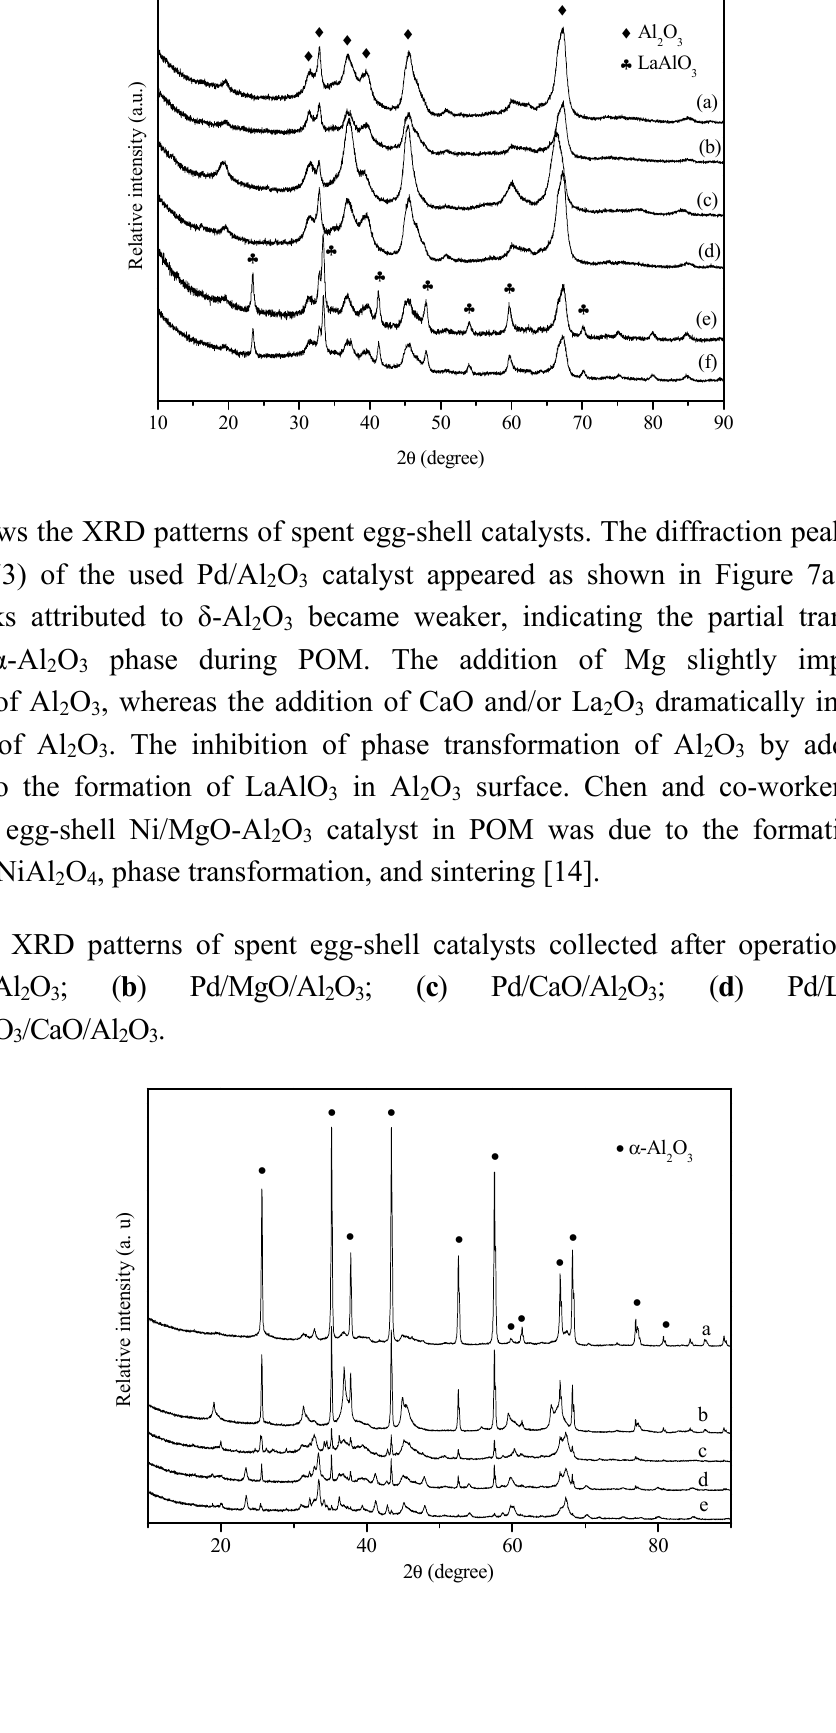
Figure 6. XRD patterns of support and egg-shell catalysts reduced at 750 °C. ( a ) Al